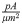
Dynamics of the Ca2+ concentration in the intracellular compartment during synaptic activation for different values of the maximal pump current of the Na+/Ca2+ exchanger (INCXmax).The astrocytic compartment was stimulated for 200 seconds with a Poisson spike train of 100 Hz. The corresponding glutamate concentration in the extracellular compartment as a function of time was calculated using the Tsodyks and Markram model. a [Ca2+]i as a function of the volume ratio (ratioER) of internal Ca2+ stores and the maximal pump current of the Na+/Ca2+ exchanger (INCXmax). The upper and lower symbols denote the average height of peaks and troughs of the emerging Ca2+ oscillations (in [μM]). In case no oscillations were present symbols denote the average concentration of Ca2+ over the stimulation period. b-d Time course of the Ca2+ concentration for ratioER = 0 and INCXmax equal to 0 pAμm2 (blue), 0.01 pAμm2(gray) and 1 pAμm2(red). e-g Time course of the Ca2+ concentration for ratioER = 0.15 and INCXmax equal to 0 pAμm2 (blue), 0.01 pAμm2(gray) and 1 pAμm2(red).